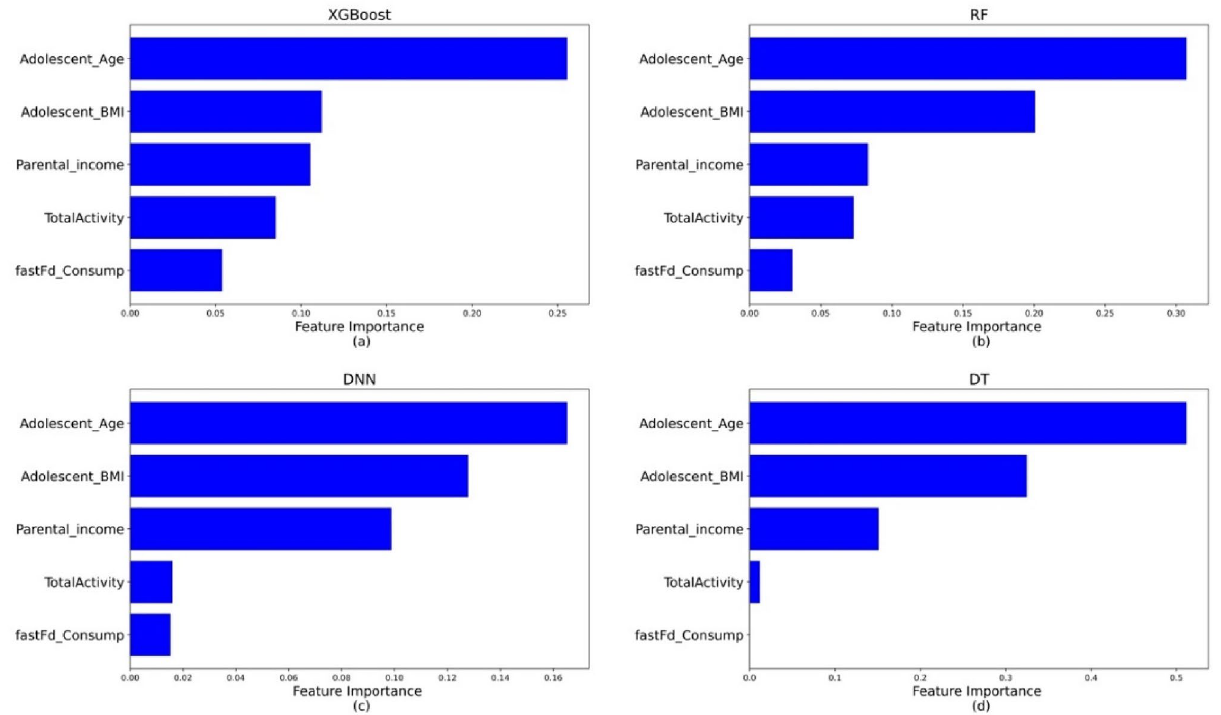
Figure 4. Permutation feature importance plot of the ML models. Higher value corresponds to a more important feature in predicting CVD risk. The plot is created for ( a ) XGBoost, ( b ) RF, ( c ) DNN, ( d )